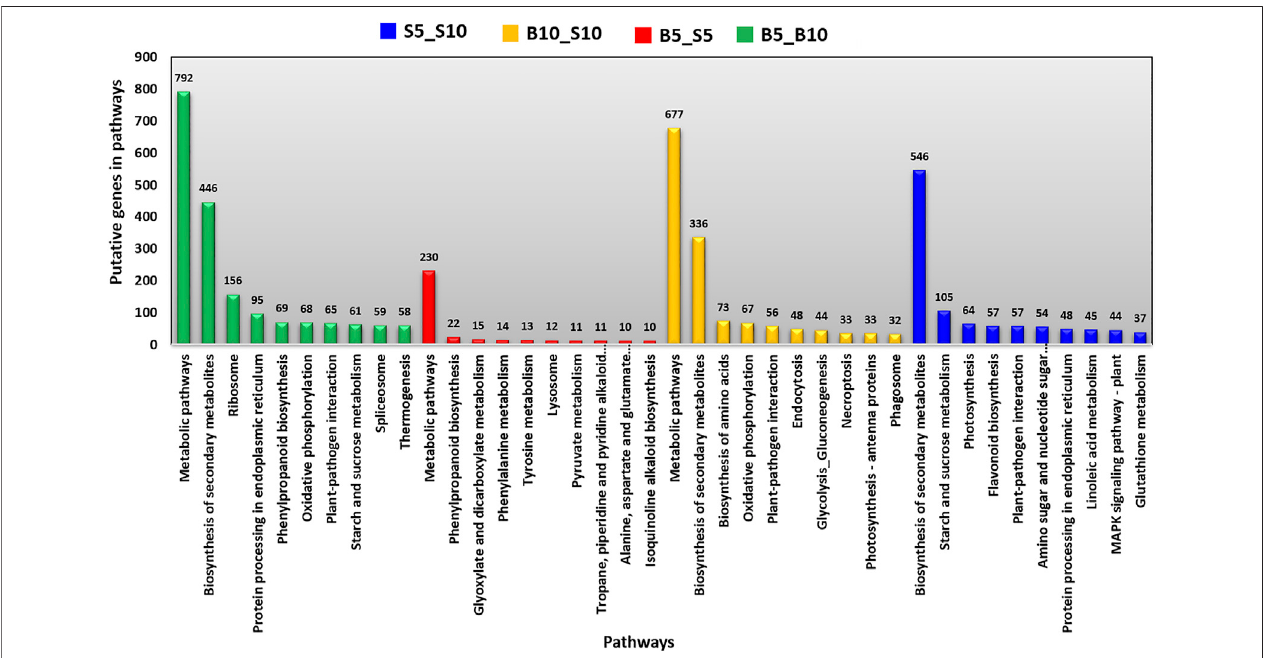
FIGURE 7 | List of top 10 pathways revealed by KEGG enrichment